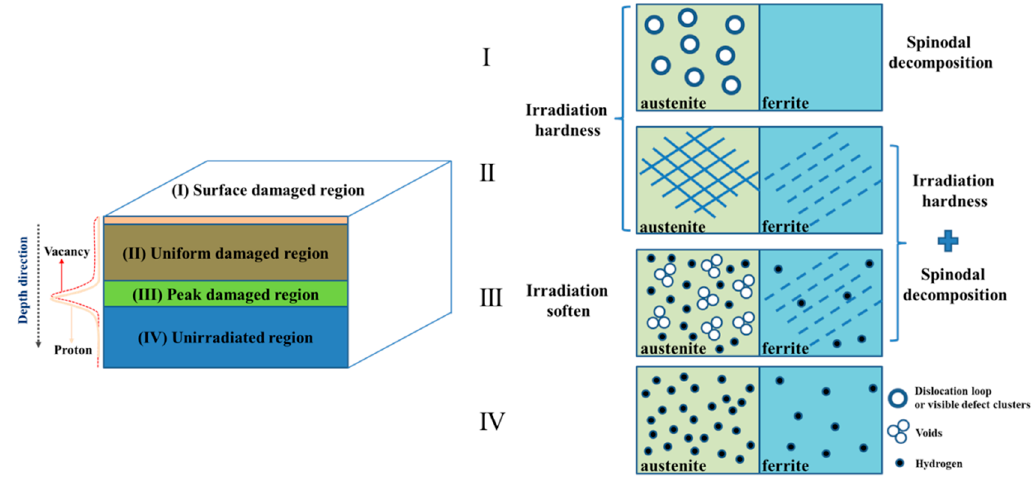
Figure 6. Schematic diagram showing how proton irradiation affects the hardness of austenite and ferrite in different regions.